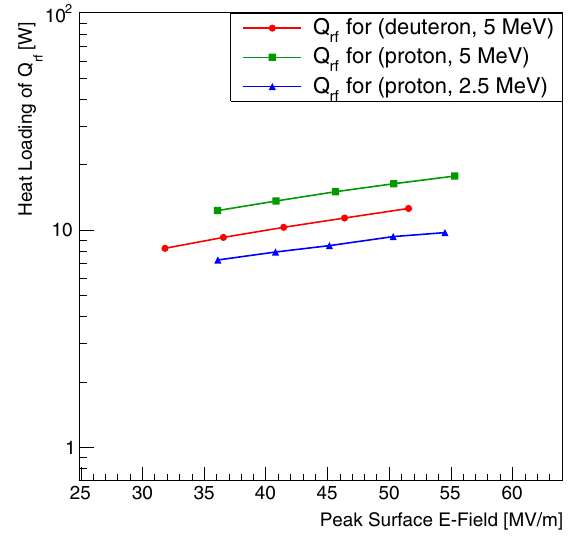
FIG. 13. Heat loading owing to rf resistance as a function of peak surface-E field.